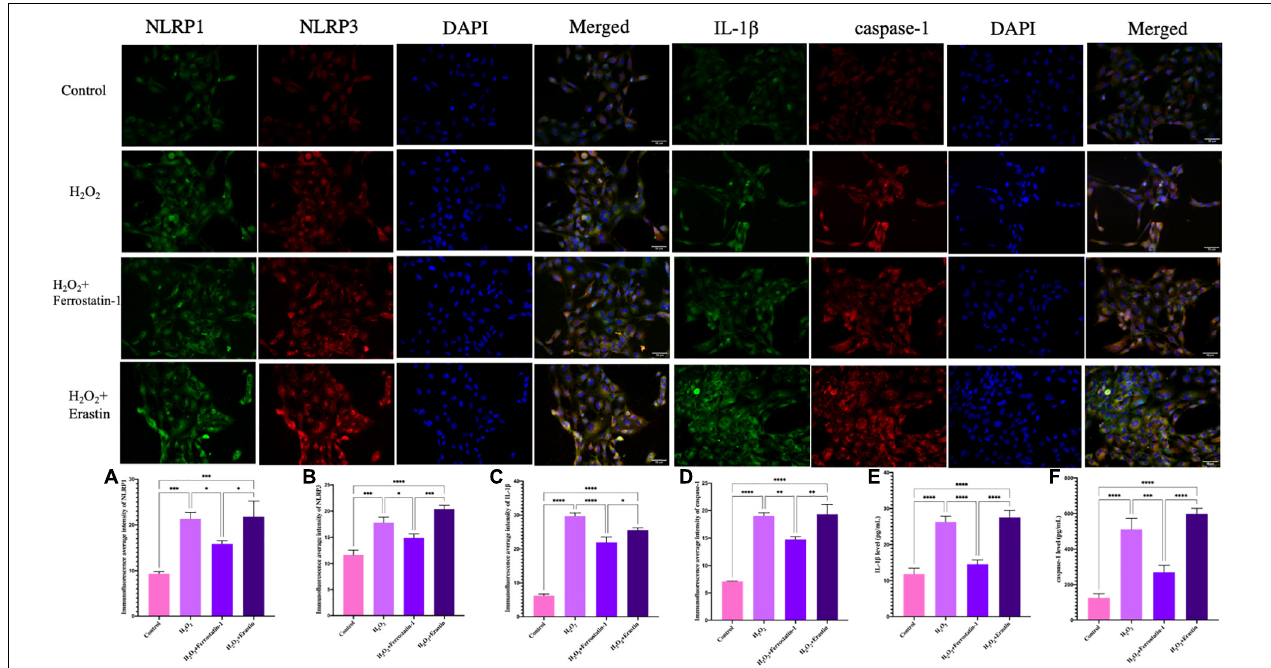
FIGURE 5 | Inflammasome-related protein expression in HTR-8/SVneo cells, as determined by immunofluorescence. Rabbit anti-NLRP1 monoclonal antibody (green) and DAPI staining were used to visualize nuclear (blue) immunolabeling. Scale: 50 µ m. Nuclear DAPI staining (blue) with rabbit anti-NLRP3 monoclonal antibody (red) immunostaining as shown by fluorescence microscopy. Scale: 50 µ m. Inflammasome-related protein expression in HTR-8/SVneo cells, as determined by immunofluorescence. Rabbit anti-IL-1 β monoclonal antibody (green) and DAPI staining were used to visualize nuclear (blue) immunolabeling. Scale: 50 µ m. Nuclear DAPI staining (blue) with rabbit anti-caspase-1 monoclonal antibody (red) immunostaining, as determined by fluorescence microscopy. Scale: 50 µ m. Mean immunofluorescence intensity of inflammasome-associated proteins: (A) NLRP1, (B) NLRP3, (C) IL-1 β , and (D) caspase-1. (E) The levels of IL-1 β in HTR-8/SVneo cells, as detected by ELISA. (F) The levels of caspase-1 level in HTR-8/SVneo cells, as detected by ELISA (* P < 0.05, ** P < 0.01, *** P < 0.001, and **** P < 0.0001).Values represent means ± SD, n = 3 per group.